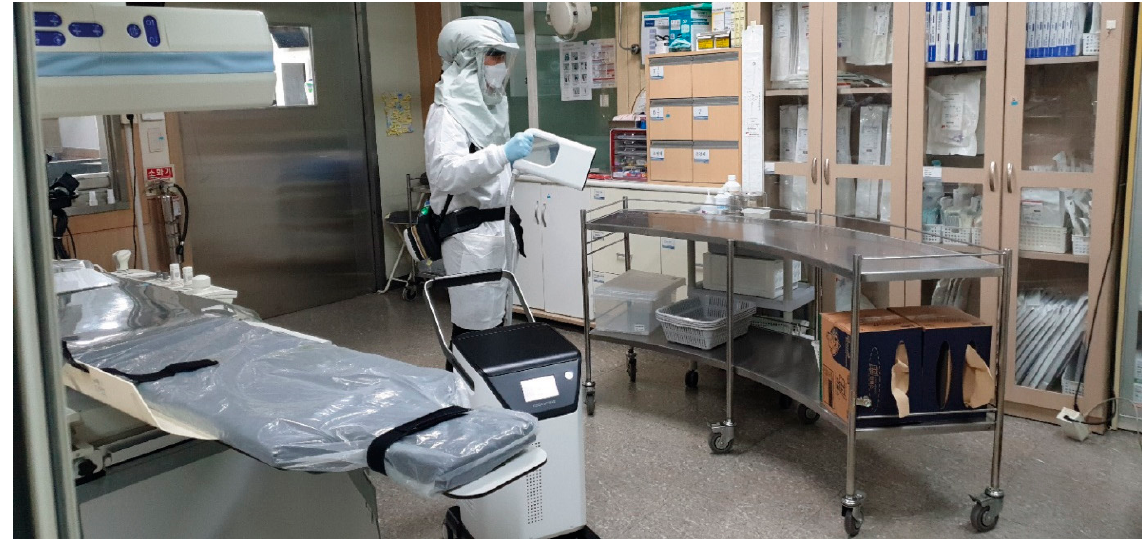
Figure 1. Plasma-treated hydrogen peroxide mist disinfection in a hospital environment using a PlaClin ® disinfector and disinfectant containing 5.9% w/w hydrogen peroxide.